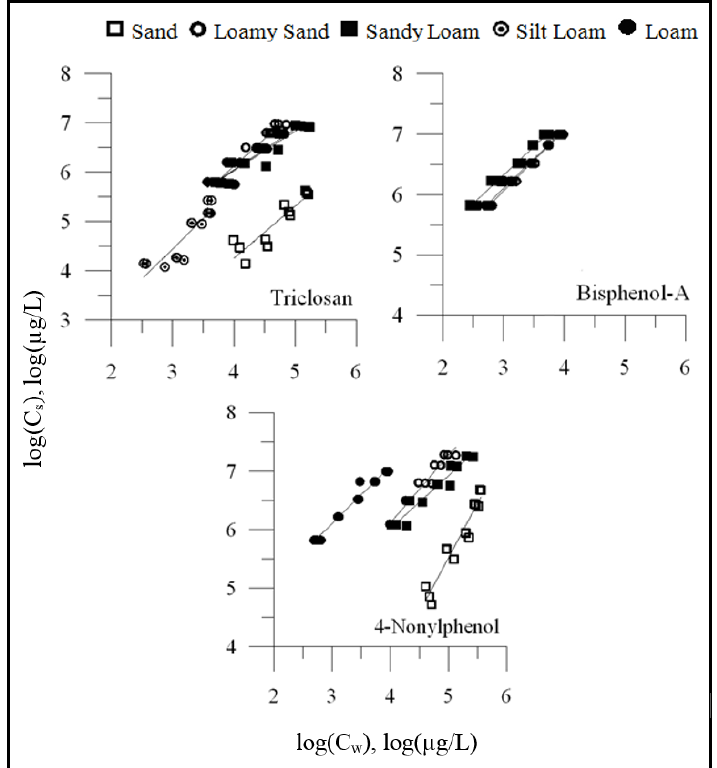
Figure 1. Sorption isotherms for TCS, BPA, and NP for soil isotherm data with an R 2 value greater than